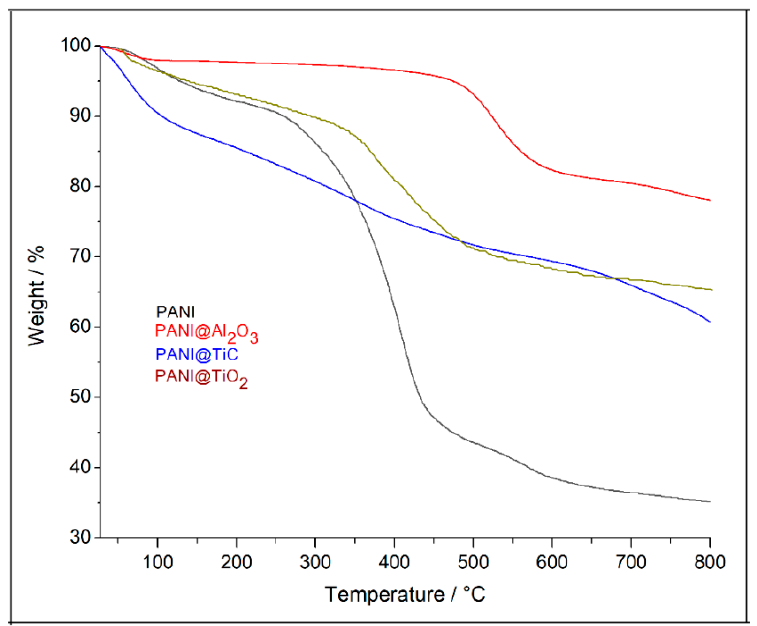
Figure 6. Thermogravimetric analysis (TGA) curves of PANI, PANI@Al 2 O 3 , PANI@TiO 2 , and PANI@TiC.